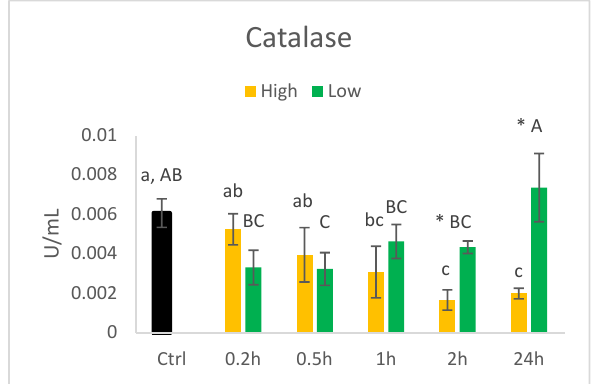
Figure 8. Activity (U/mL) of catalase in HT29 cells exposed to high (140 uM) or low (0.014 µM) concentrations of HHE. Data (n = 4) are means shown with standard error mean. Significant differ- ences between control (Ctrl) and different time points within Low or High groups are indicated with different letters (High: lower letters, Low: capitalised letters) evaluated with Tukey–HSD ( p < 0.05). Significant differences between Low and High are evaluated by Student’s t -test and indicated with asterisk (*) at specific time points.